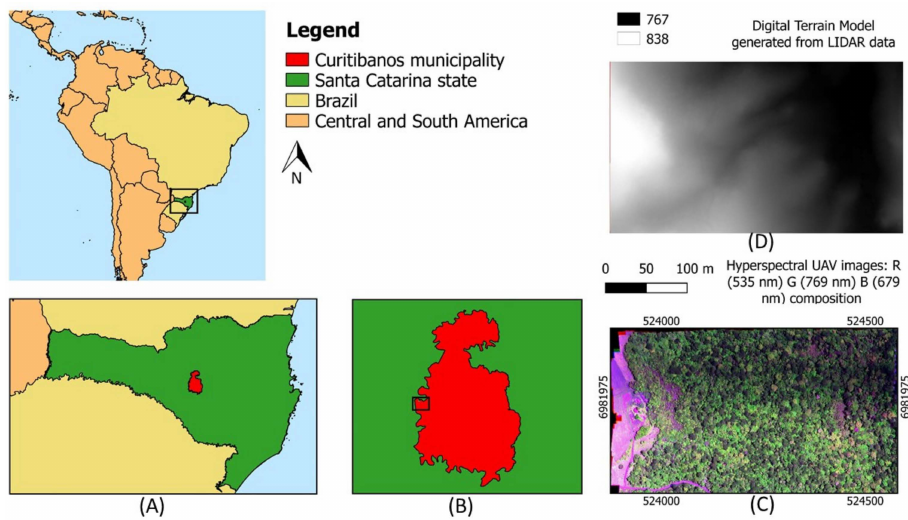
Figure 1. Study area location. ( A ) Santa Catarina State. ( B ) Curitibanos municipality. ( C ) Hyperspectral UAV image R (535 nm) G (769 nm) B (679 nm). ( D ) Digital Terrain Model.